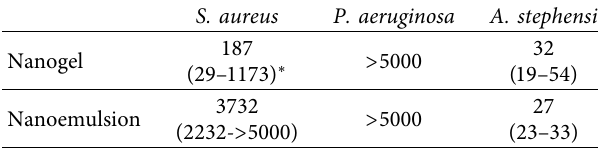
Figure 3: Antibacterial activities of EGEO-nanogel and EGEO-nanoemulsion against S. aureus . ∗ : P < 0 . 05, ∗∗∗ : P < 0 . 001. Table 3: Obtained IC 50 ( μ g/mL) and LC 50 ( μ g/mL) values of the nanogel and nanoemulsion against targeted bacteria and A. stephensi